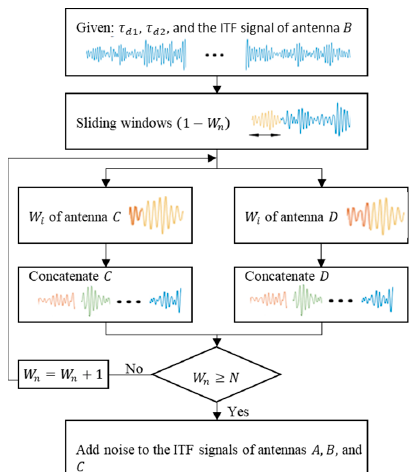
Figure 6. The general procedure of Simulating ITF Signal. Where W n is the window length (i.e., 256 samples), W i , i = 1, ... , N is window counter, N is the total number of sliding windows of the processed ITF signal, W n + 1 is the temporal shift for subsequent windows (1 sample).